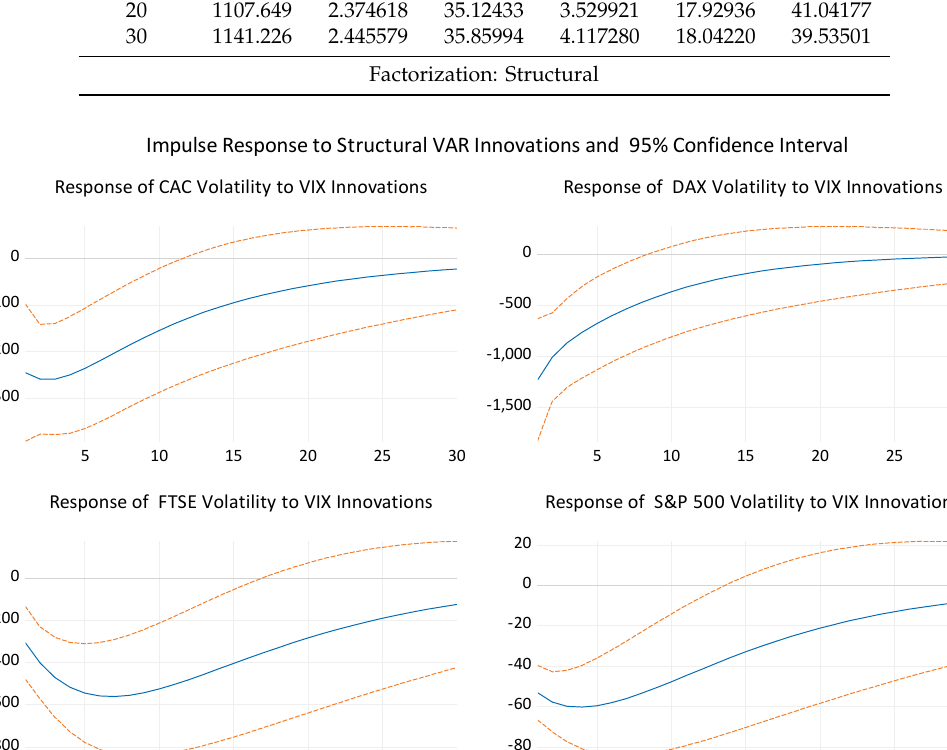
Figure 7. Responses of volatility in equity indices to structural innovations in VIX. Estimates and two standard deviation confidence band are in solid and dotted lines. SVAR lag order is one. 13 August 2015 − 17 May 2016. Table 3 presents the decomposition of the forecast error of the equity indices explained by the SVAR variables in the second subperiod. A significant portion of one day ahead forecast error variations in the forecast error of volatility in all indices except S&P 500 are due to the shocks related S&P 500. For instance, S&P 500 shocks account for 41% to over 50% of one day ahead forecast error